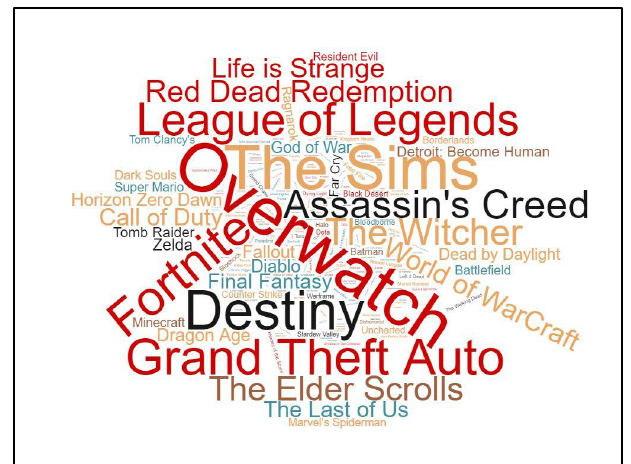
Figure 7. Word cloud depicting the listed games. The bigger it is, the more it was mentioned.